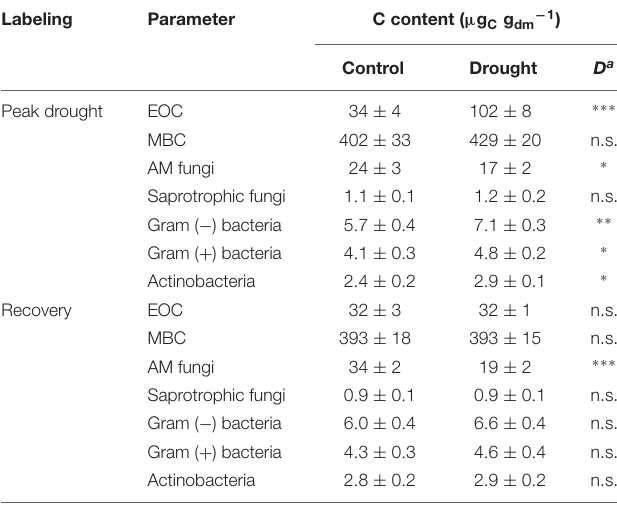
TABLE 3 | Effects of drought on the sizes of soil carbon and microbial marker lipid pools for the peak drought and the recovery labeling campaigns. Labeling